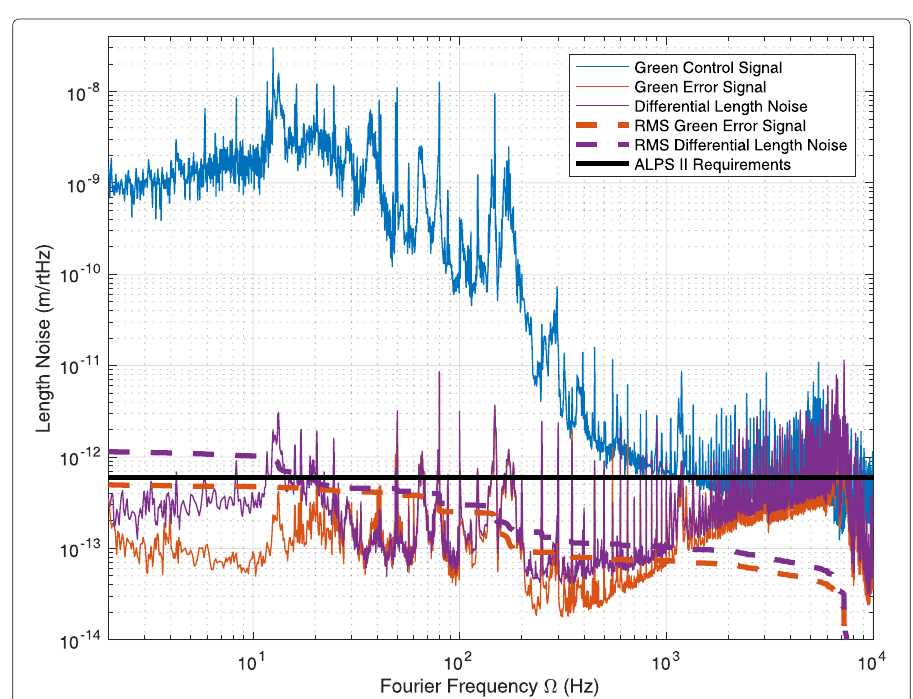
Fig. 3 Length noise measurement. Amplitude spectral densities of green control (solid blue trace) and error (solid red trace) signal of the PDH control loop calibrated in length noise as well as the beatnote frequency measurement (solid purple trace) representing the differential length noise. For a comparison with the ALPS II requirements the error signal and the beatnote frequency measurement are filtered by a cavity pole frequency of 6Hz in post processing and its corresponding integrated RMS is shown with the dashed lines